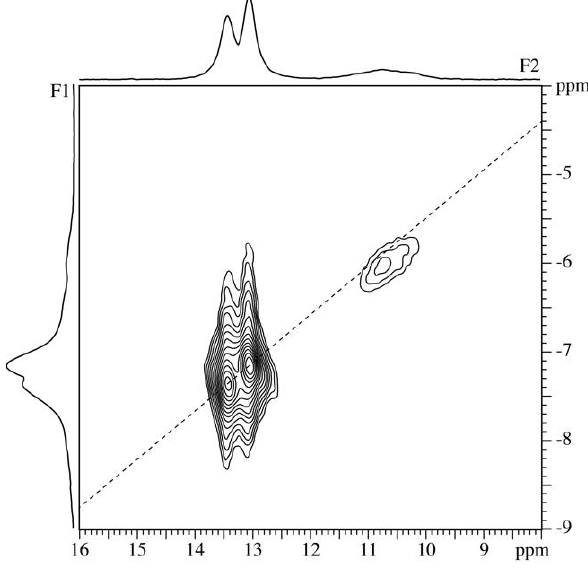
Figure 5. 27 Al MQMAS NMR spectrum (22.3 T, ν R = 25 kHz) of Cr-AFt acquired with the three-pulse z-filter pulse sequence and 1 H decoupling during acquisition and the MQ excitation and evolution periods. A spectral width of 45 kHz was used in both dimensions, along with 330 t 1 increments in the indirect dimension, 72 scans for each t 1 increment, and a relaxation delay of 2 s. The dashed line represents pure chemical shift evolution ( P Q = 0).